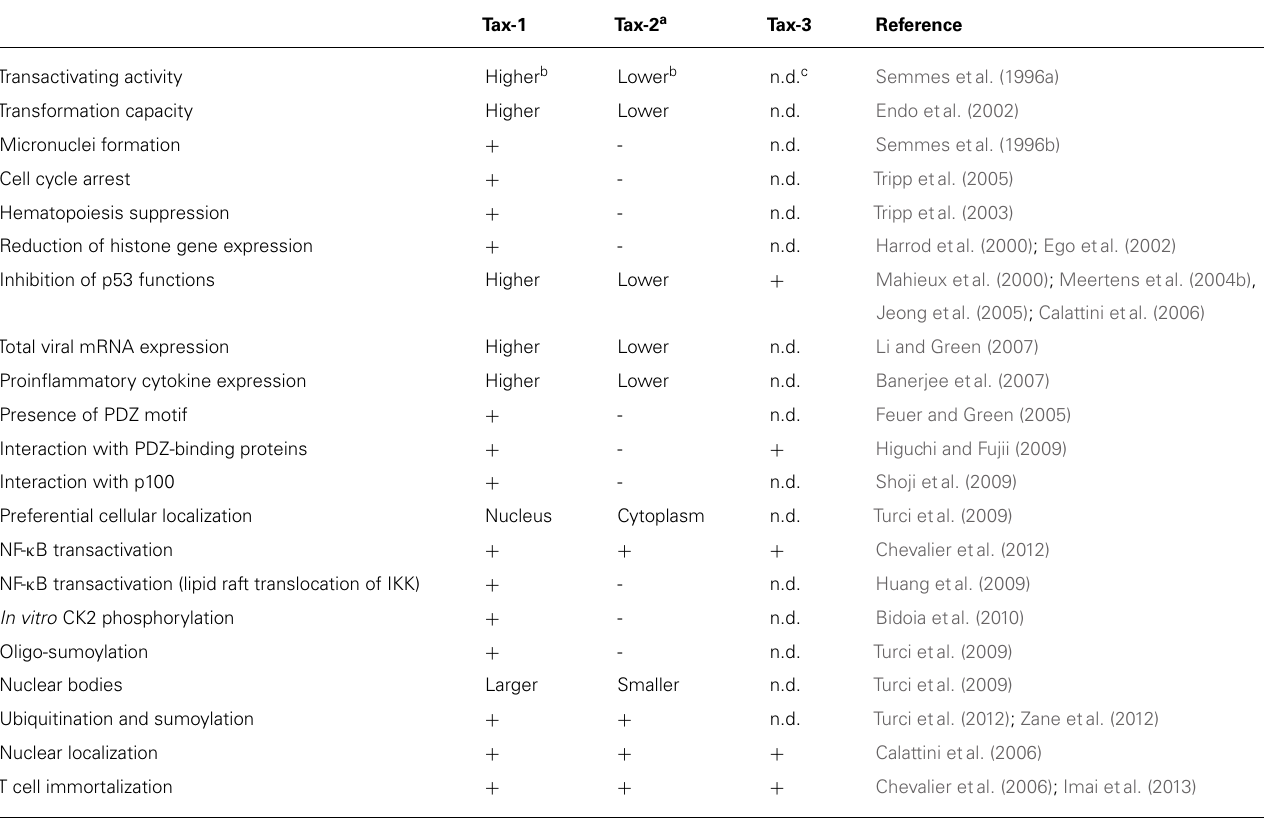
Table 2 | Summary of main functional and structural differences betweenTax-1,Tax-2,